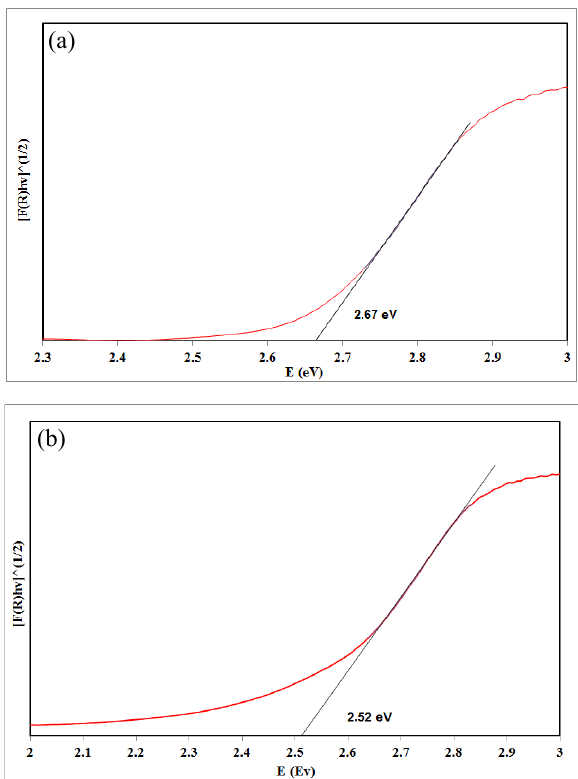
Figure 6: DR-UV spectra of bismuth oxide synthesised using (a) H 2 C 2 O 4 -settling agent and (b) Na 2 CO 3 -setteling agent.